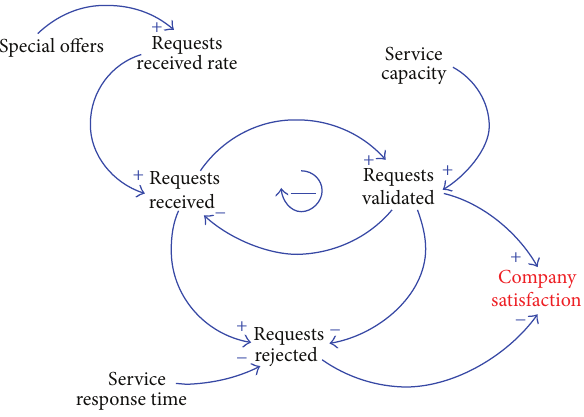
Figure 1: Causal loop